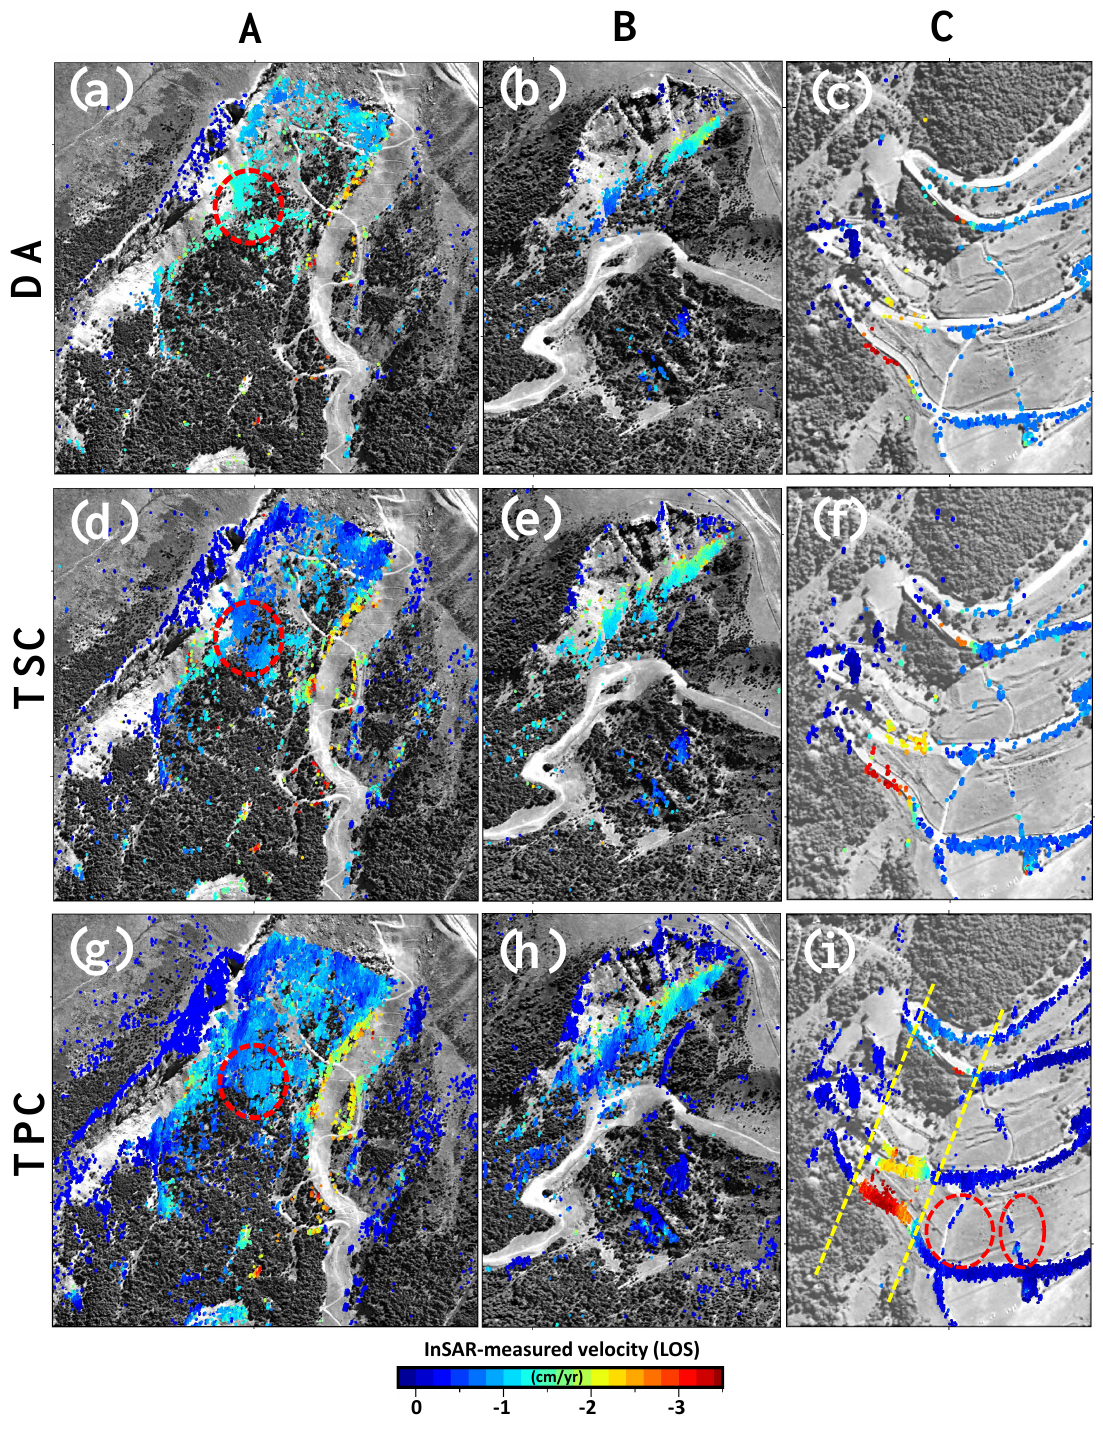
Figure 9. The close-up of the three subareas limited by red rectangles in Figure 8a–c. ( a – c ) are the results of the D A method, ( d – f ) obtained by the TSC method and ( g – i ) obtained by the TPC method. Red ellipses highlight areas commented in Section 4.1. Yellow dashed lines highlight the edges of the